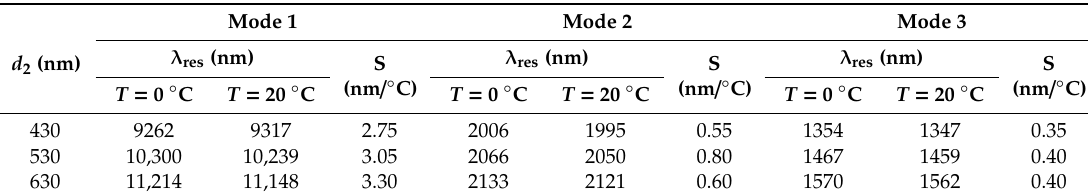
Table 3. Three modes and their corresponding temperature sensitivity (S) of the proposed structure with r 1 = 24 nm under testing temperature ( T = 0 ◦ C and T = 20 ◦ C) versus di ff erent d 2 with 430 nm, 530 nm and 630 nm, respectively.